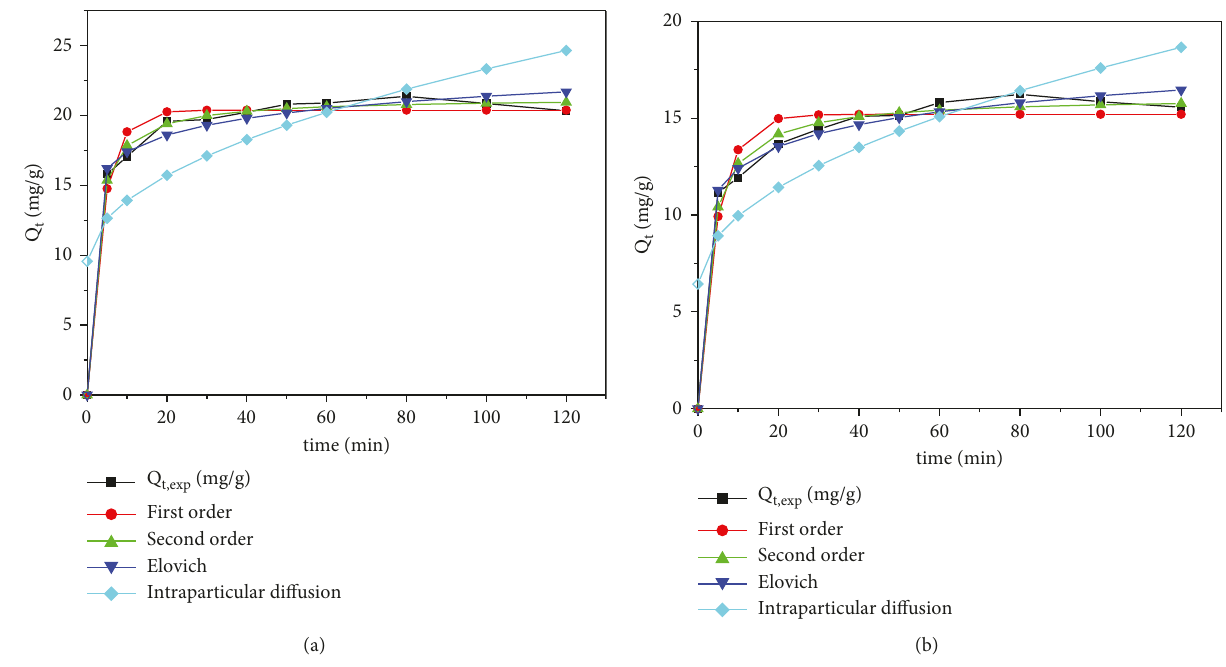
Figure 9: Non-linear kinetic adsorption plot onto CuTart (a) and CuFum (b). Table 4: Comparison of adsorption capacity of phenacetin. Adsorbents Quantity of phenacetin